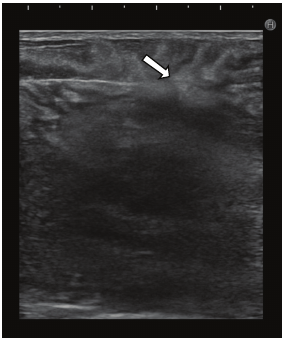
Figure 2: Ultrasound showing a hypoechoic mass with a hypere- choic boundary toward the subcutaneous tissue